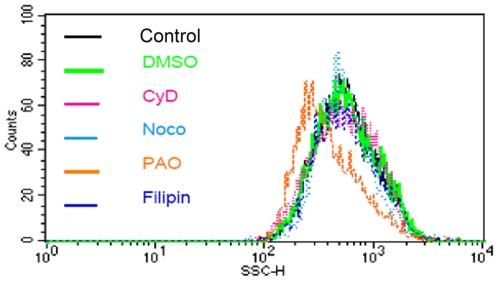
The endocytotic pathway of SPIO particle uptake in macrophages was measured by SSCs via flow cytometry after the cells were treated with different endocytotic inhibitors.There was a left shift in the cell distribution following treatment with the clathrin inhibitor phenylarsine oxide prior to SPIO particle incubation. The other inhibitors tested showed no effect on cellular granularity. This finding suggested that the clathrin receptor plays a major role in the mechanism of cellular uptake of SPIO particles.